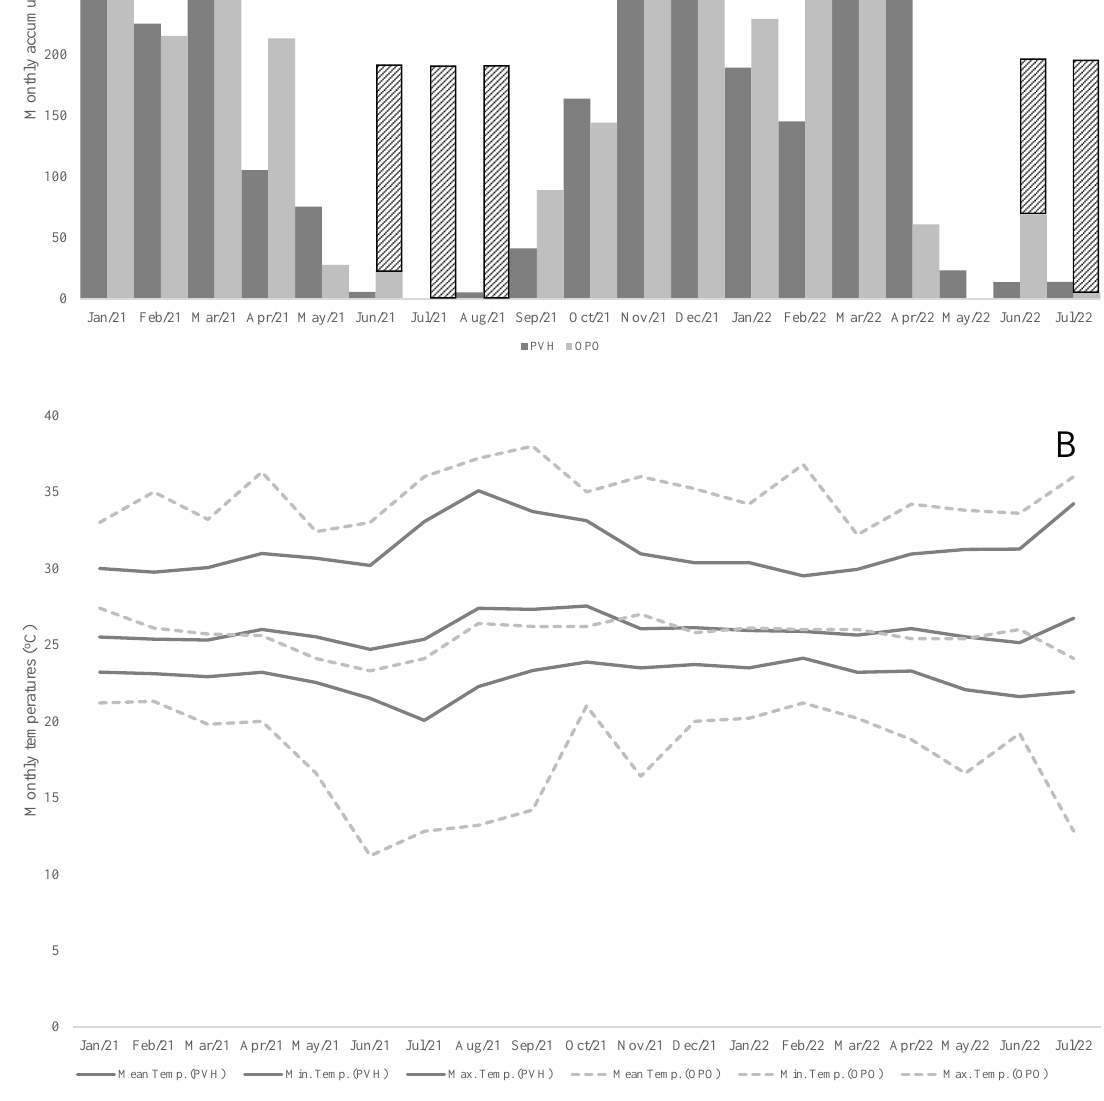
Figure 1. Monthly accumulated rainfall ( A ) and maximum, mean, and minimum temperatures ( B ) from January 2021 to July 2022 in the environments of Porto Velho and Ouro Preto do Oeste, measured in the smart weather stations of CEPLAC and of the Usina de Santo Antônio. The razored area ( A ) represents supplementary irrigation managed in the months of June, July, and August in the Ouro Preto do Oeste environment.